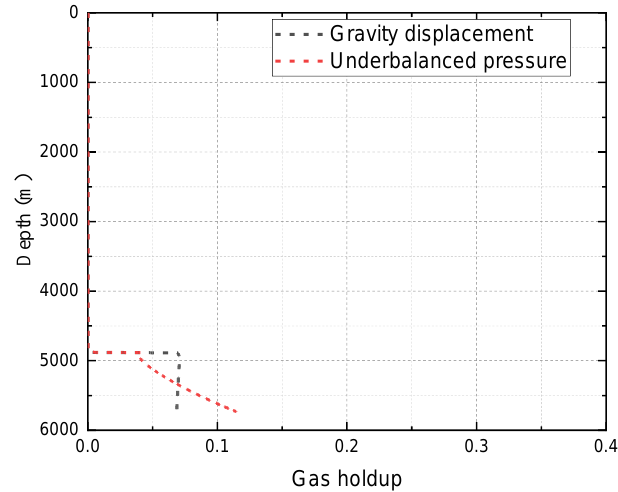
Figure 3. Distribution of the wellbore annular gas holdup for well M. The changes in the bottomhole pressure during the underbalanced pressure gas kick and the gravity displacement gas kick are shown in Figure 4. From the beginning of gas kick to the overflow volume of 2 m 3 , the bottomhole pressure under both types of gas kicks decreases continuously with time, but the decreasing trend is different. As seen in Figure 5, there is a slightly decreasing trend in the absolute value of the change rate of the bottomhole pressure during the gravity displacement gas kick, while it keeps increasing for the underbalanced pressure gas kick.